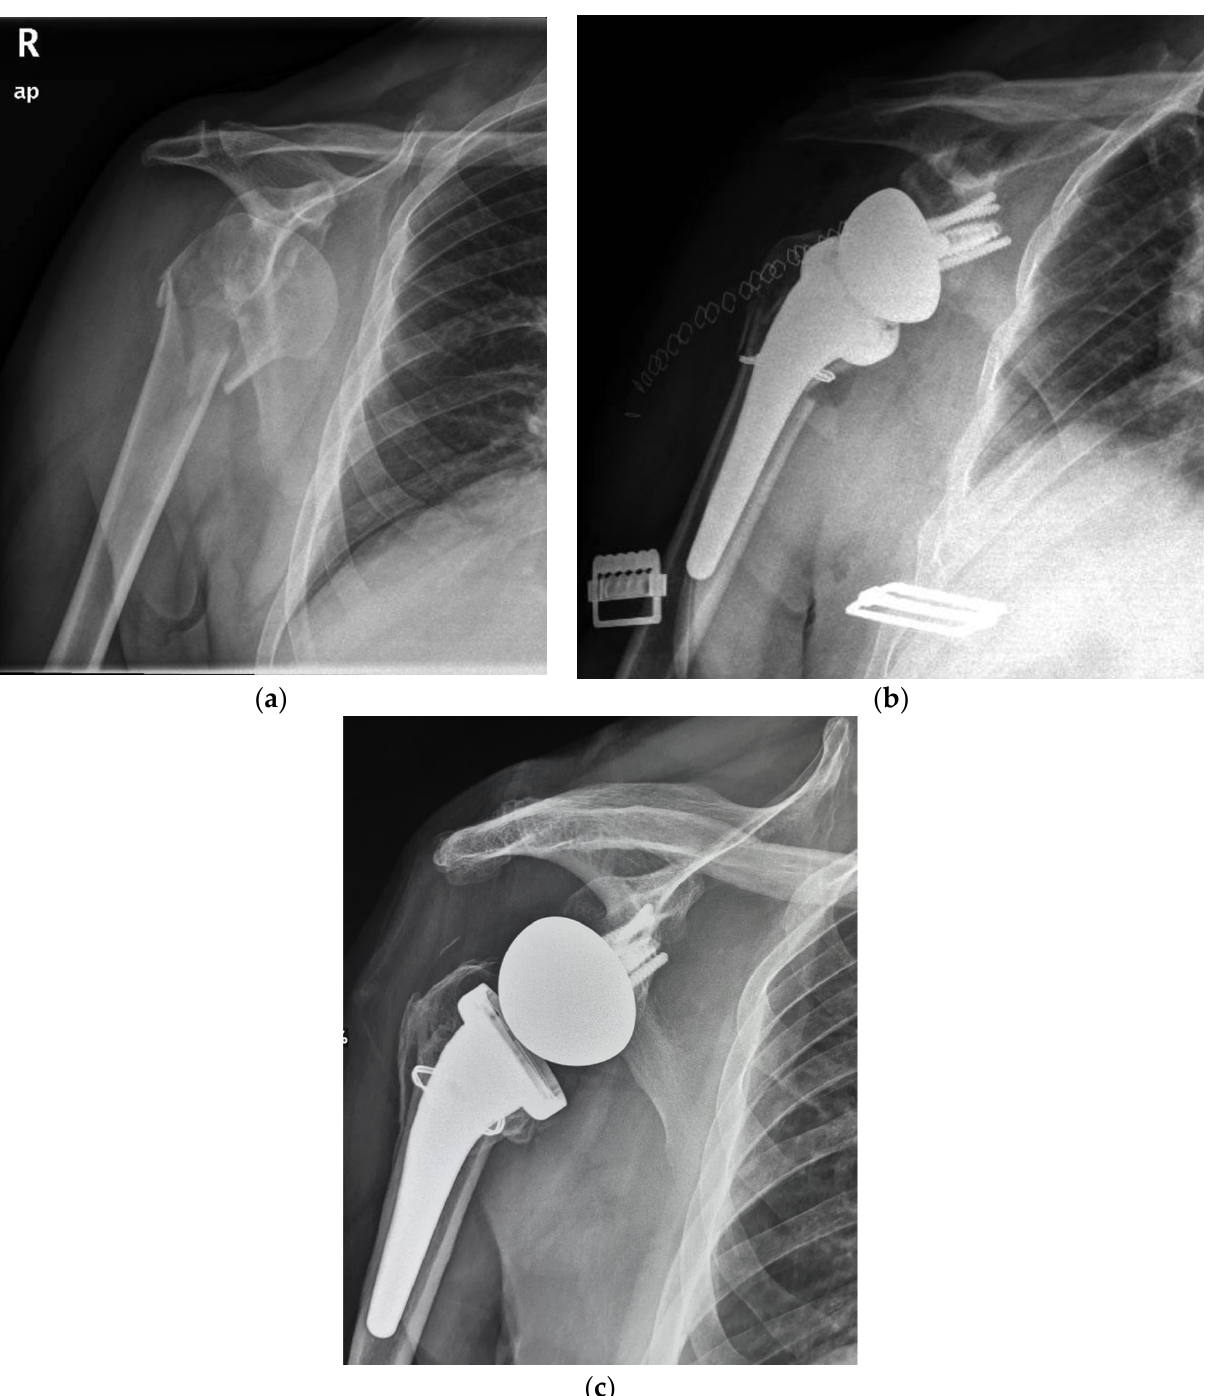
Figure 1. ( a ) Preoperative radiographic image of right shoulder showing acute (Neer three-part) proximal humeral fracture with calcar involvement. ( b ) Immediate postoperative film of right shoulder showing calcar fragment fixation with steel wire cerclage. ( c ) 5.7 years postoperative film of right shoulder showing stem subsidence and healing of tuberosity and medial